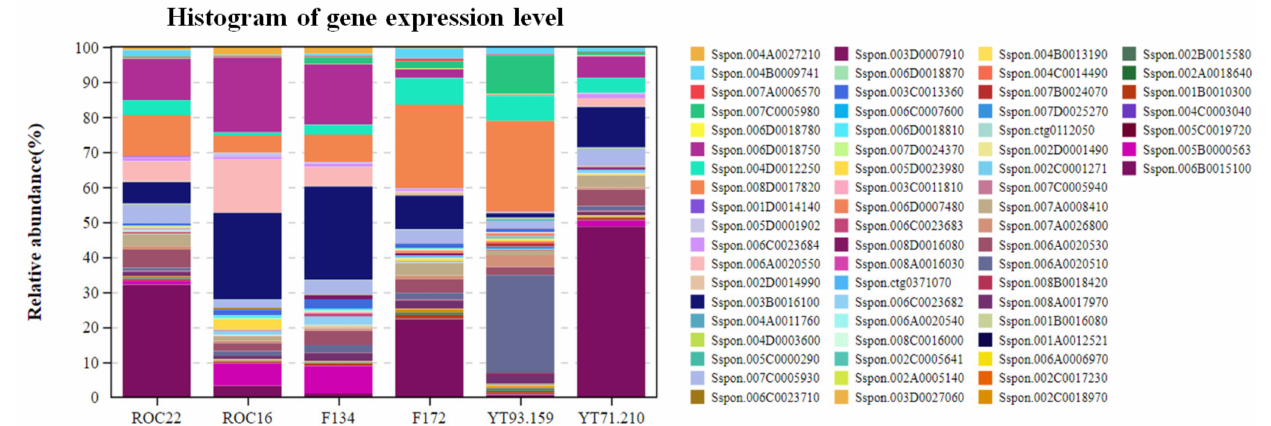
Figure 5. Transcriptomic analysis of anthocyanin biosynthesis genes in the rind of six sugarcane varieties. Heat map of gene expressions associated with anthocyanin biosynthesis (the columns represent sugarcane varieties and rows represent gene expressions from transcriptomic